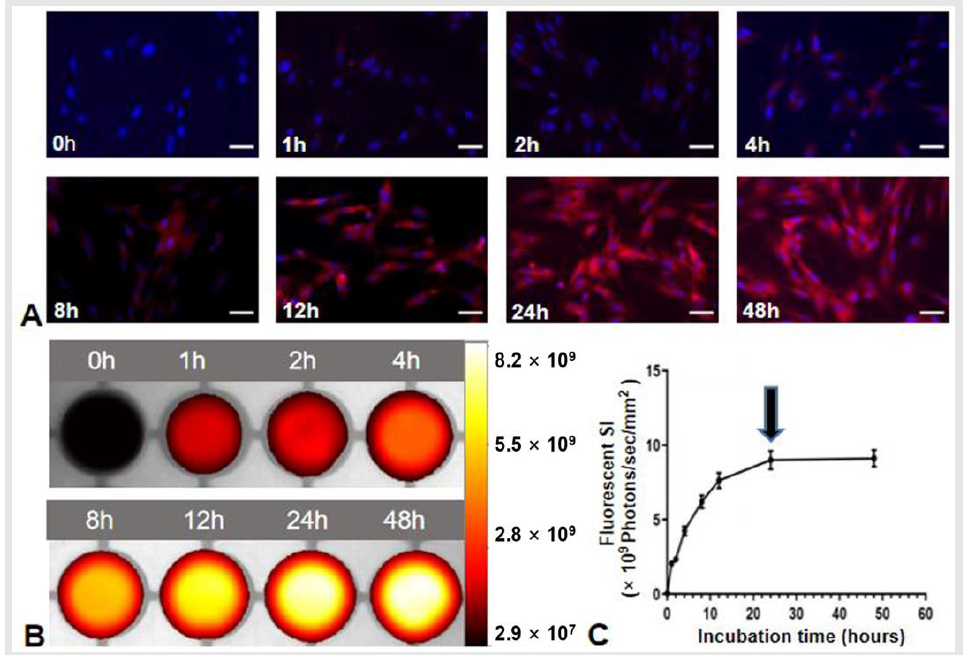
Figure 2. Optimization of indocyanine green (ICG) time window for optical imaging of ICG-treated VX2 tumor cells (ICG-cells). ( A ) Fluorescent microscopy showed that the red fluorescence emitted by ICG became more intense as the incubation time increased from 0 to 48 h . Scale bars, 50 μm. ( B ) Optical/X-ray images showing similar results, with the fluorescence signal of ICG cells reaching its peak at 24 h incubation time. ( C ) Quantitative analysis of the fluorescent signal intensity (SI) further confirmed the optimal time window at 24 h (arrow).